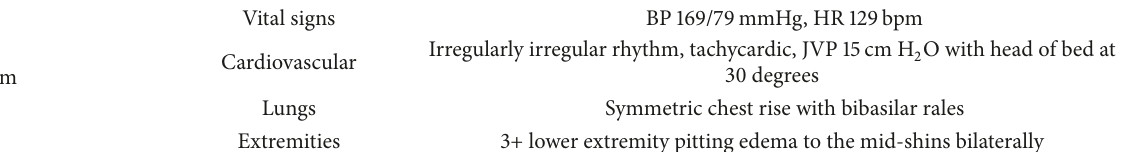
Table 2: Admission physical exam and notable labs.